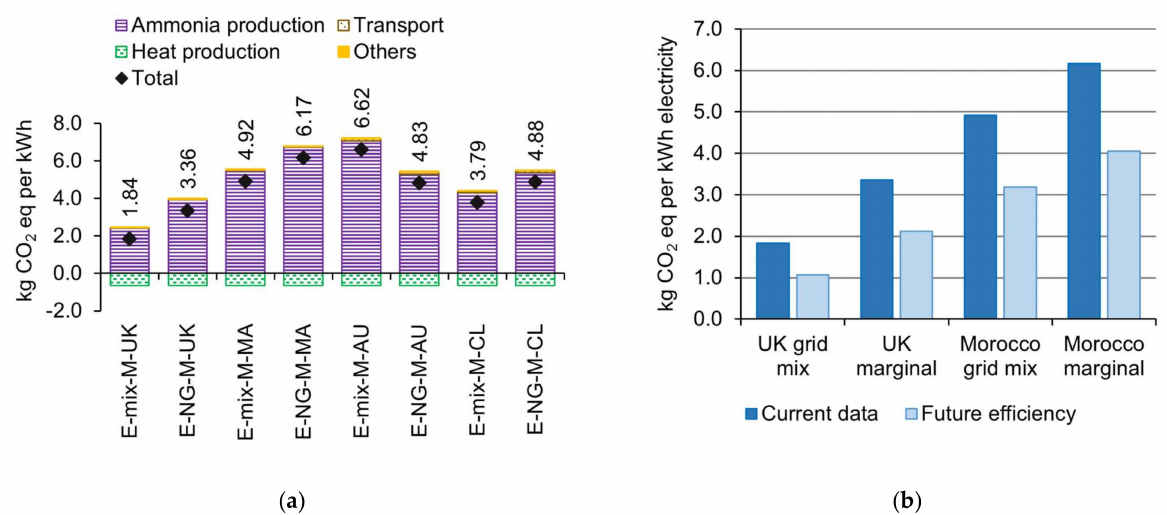
Figure 9. Global warming potential results of co-generation cycle based on ammonia, FU: 1 kWh of electricity. ( a ) comparison of different locations’ grid mixes and marginal electricity (natural gas in gas turbine power plant); ( b ) comparison of current and future efficiency of the electrolyzer and Haber–Bosch processes. E: electrolysis; mix: grid mix, NG: marginal electricity— natural gas in a gas turbine, M: mid-scale 100,000 ton per annum ammonia plant, UK: United Kingdom, MA: Morocco, AU: Australia, CL: